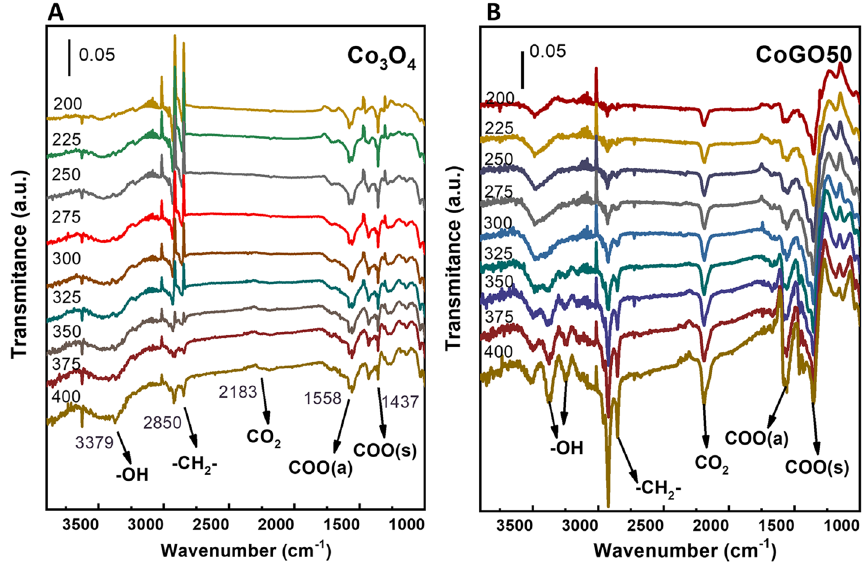
Figure 6. In situ DRIFTS spectra of ( A ) Co 3 O 4 and ( B ) CoGO50 for methane combustion at different temperature (1 vol% CH